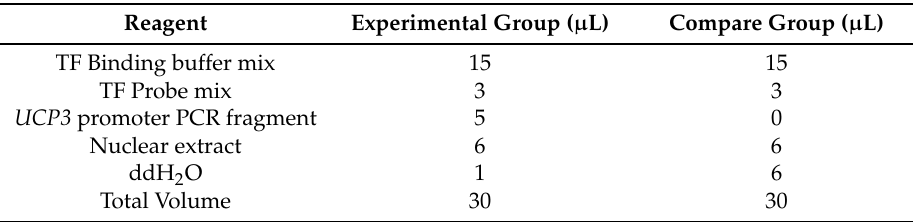
Table 5. The system of experimental group and control